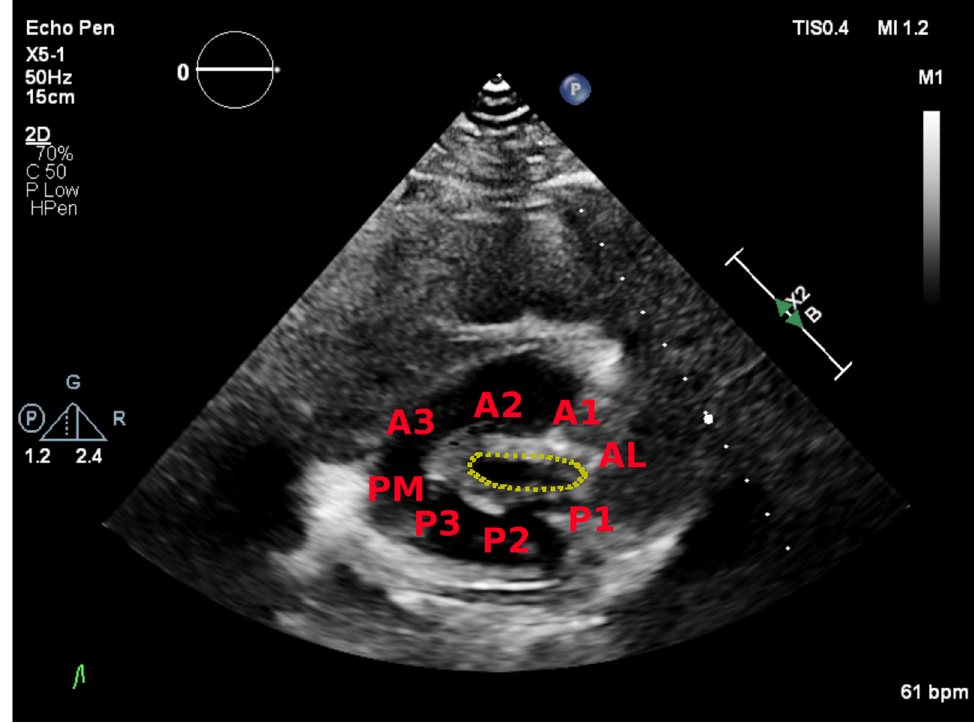
Figure 3. Parasternal short-axis view showing the posteromedial (PM) and anterolateral (AL) com- missures and the mitral